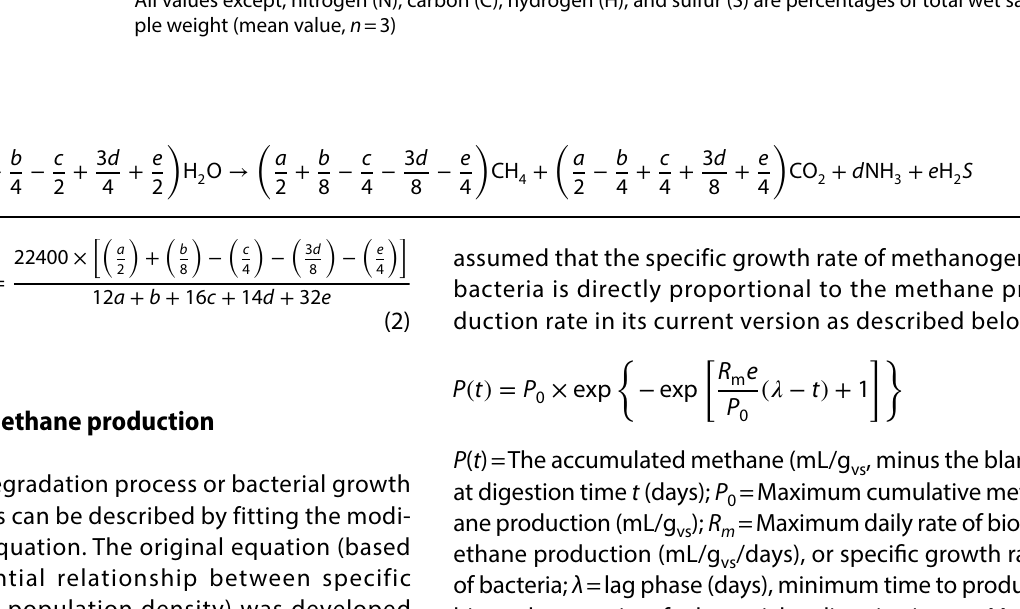
All values except, nitrogen (N), carbon (C), hydrogen (H), and sulfur (S) are percentages of total wet sam- ple weight (mean value, n